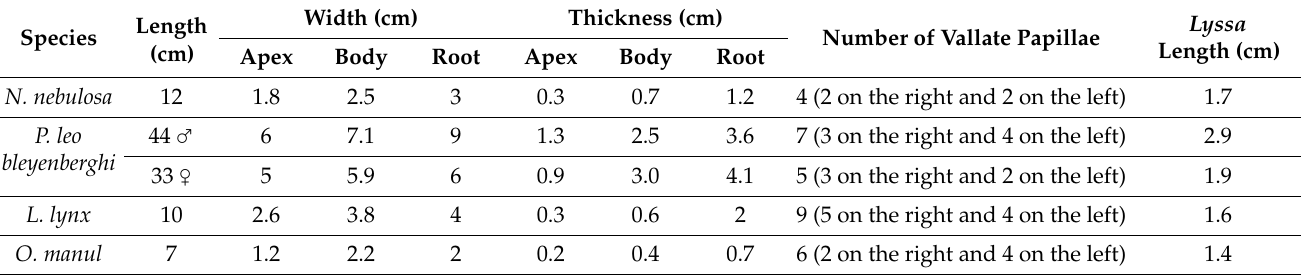
Table 2. Macroscopic measurements of the tongue, the number of vallate papillae and the length of lyssa in the four felids described in this